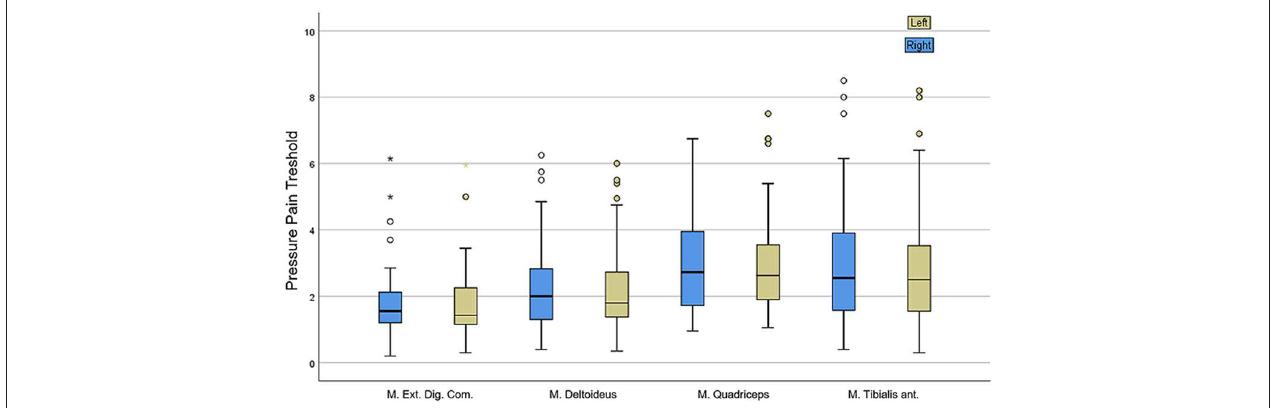
FIGURE 1 | Results of pressure pain threshold (PPT) assessment showing great variability within single